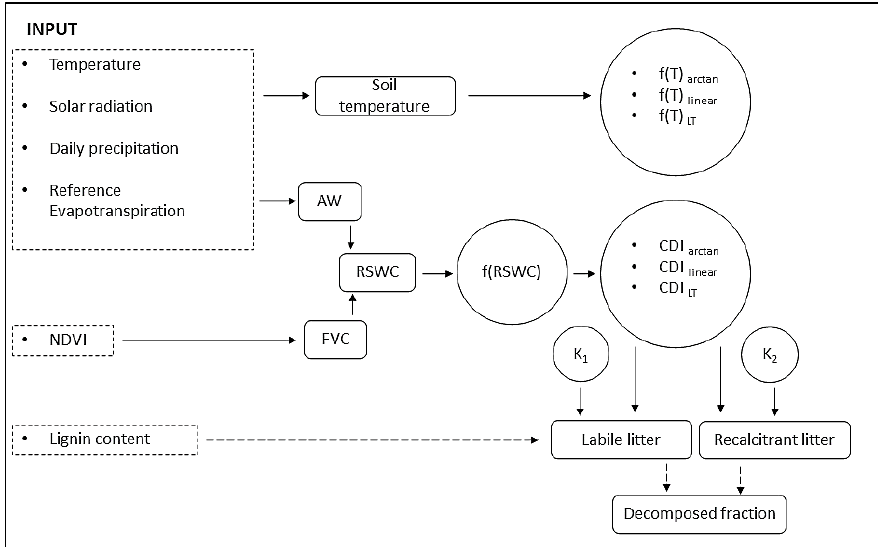
Figure 1. Conceptual diagram of the decomposition model. Dashed boxes referred to input variables, squares were stocks, rounded squares were driver variables, circles stood for specific information dealing with model control, dashed arrows denoted fluxes, and solid arrows stood for impacts. (Adapted with permission from Vitale et al. [40]. Copyright 2014, copyright iForest – Biogeo- science and Forestry).